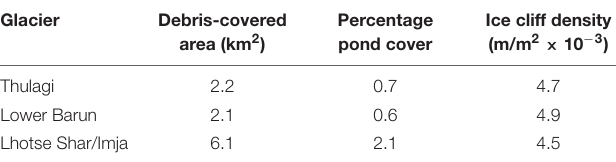
TABLE 3 | Glacier surface features in 2015. Glacier Debris-covered area (km 2 )